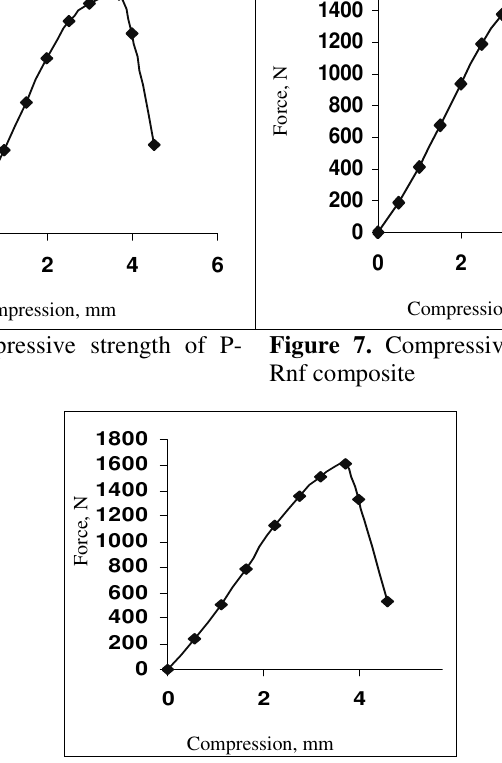
Figure 8. Compressive strength of LF- Rnf